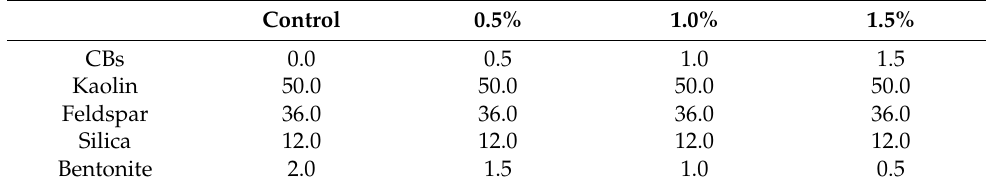
Table 2. The ratios of raw materials for ceramic mixtures.